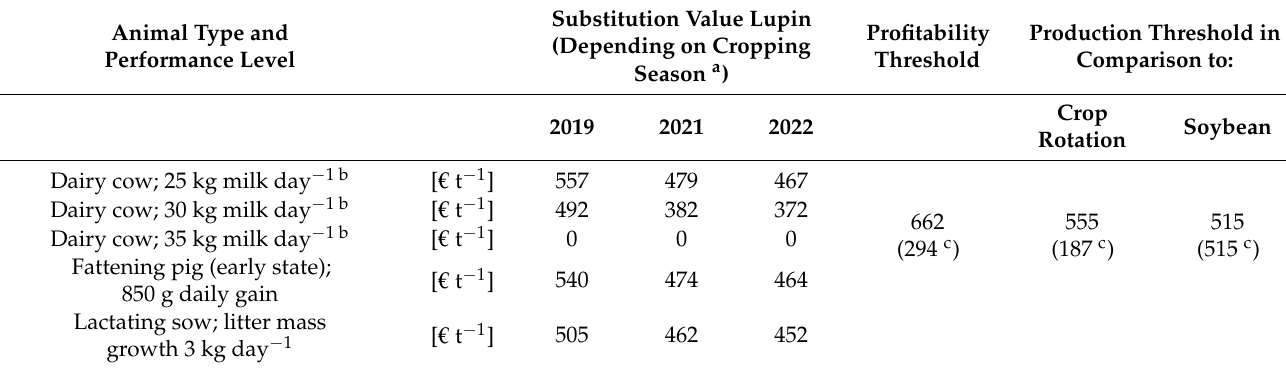
Table 5. Comparison of substitution values and producer price